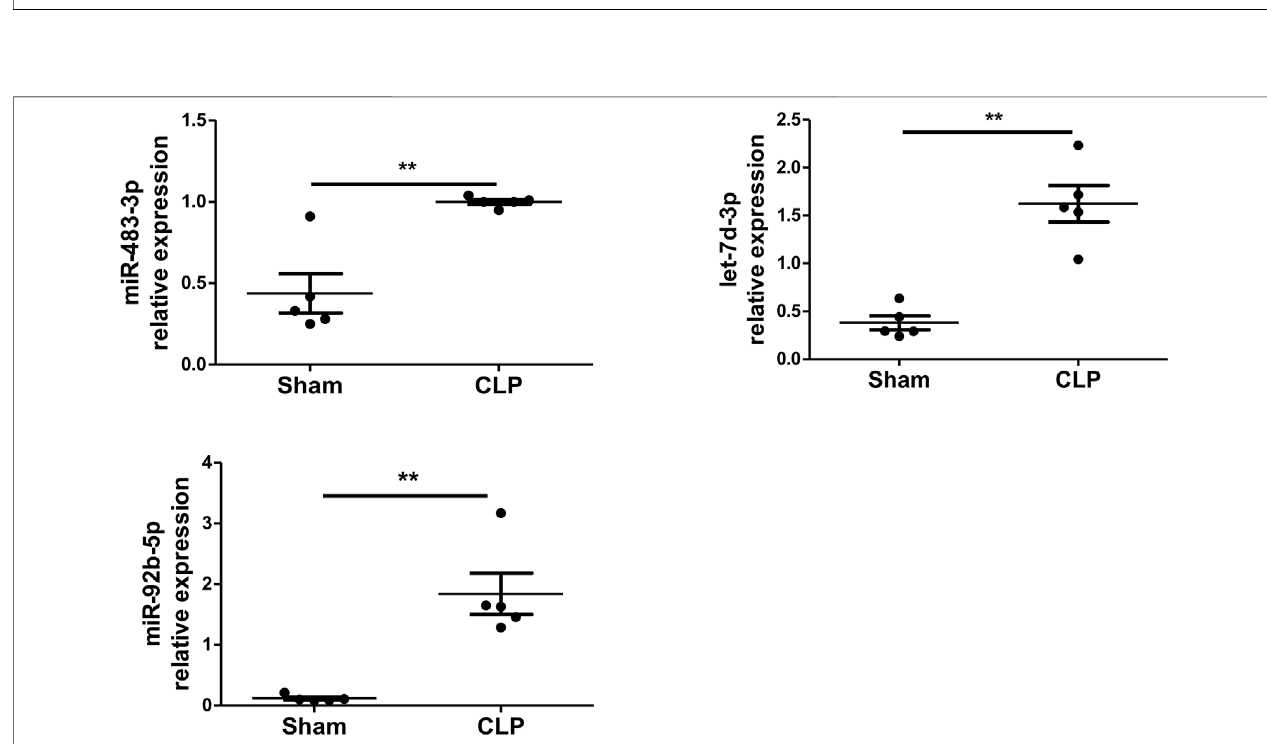
FIGURE3| miR-483-3p,let-7d-3p,andmiR-92b-5pexpressioninplasmaEVsusingamousemodelofsepsis.PlasmaEVswereisolatedfromC57BL/6miceafter 24 hofshamorCLPsurgery.ExpressionofmiR-483-3p,let-7d-3p,andmiR-92b-5pwasdetermined via qRT-PCR.Dataarepresentedasmean±SD, n =5.** p < 0.01.